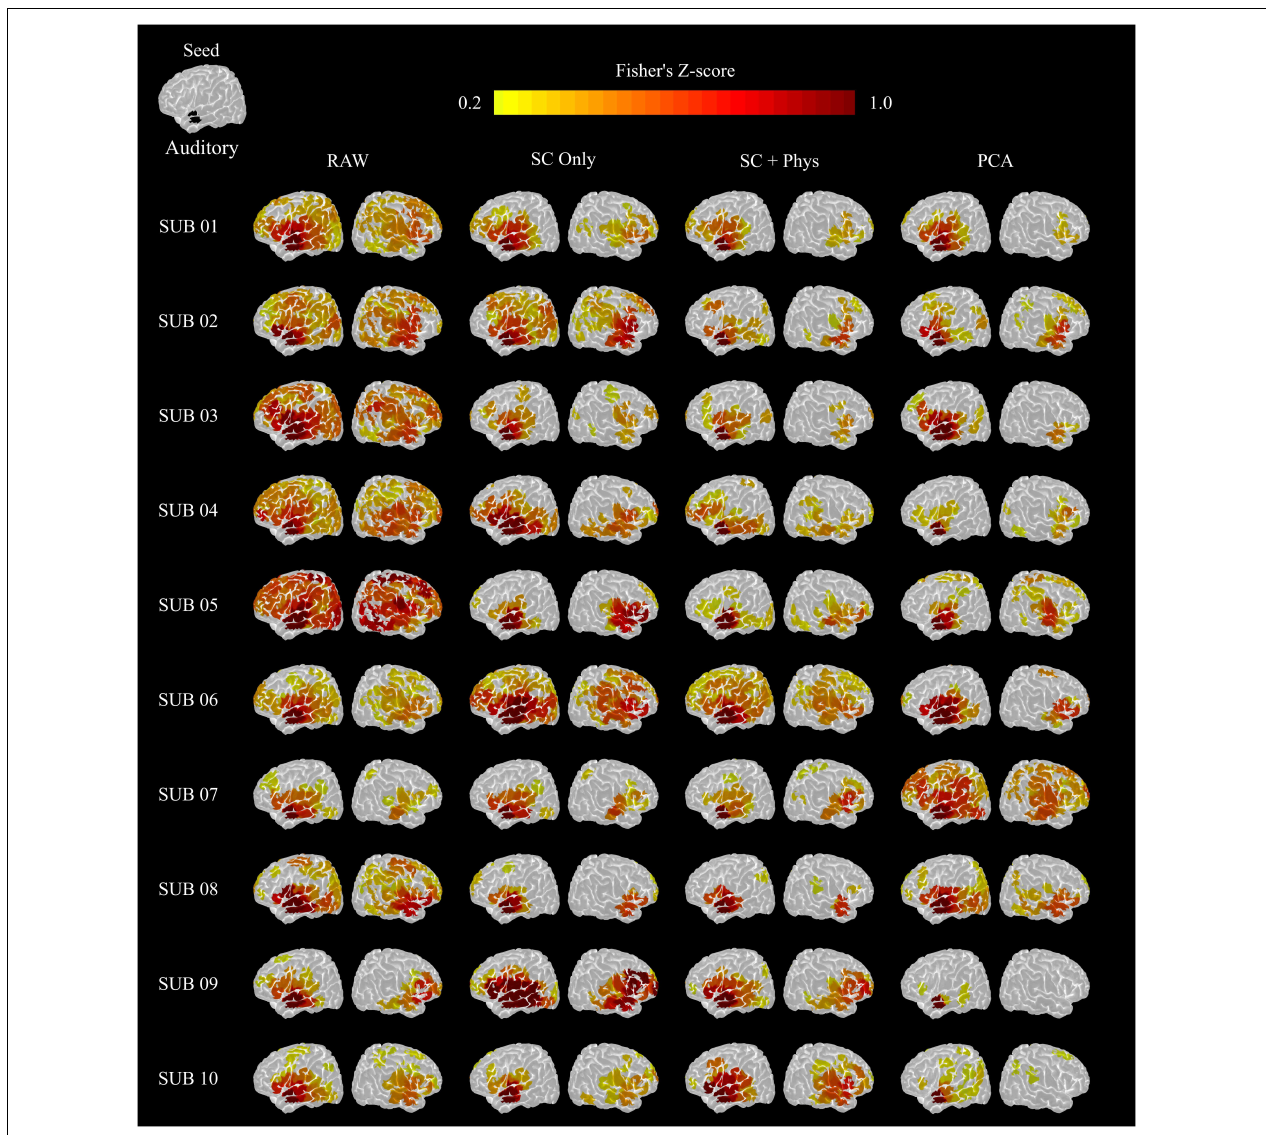
FIGURE 5 | Auditory networks extracted from the HbT correlation matrix for each participant. The seed was located in the left superior temporal gyro (top left image). The removal of systemic physiology better localized the rsFC networks in most